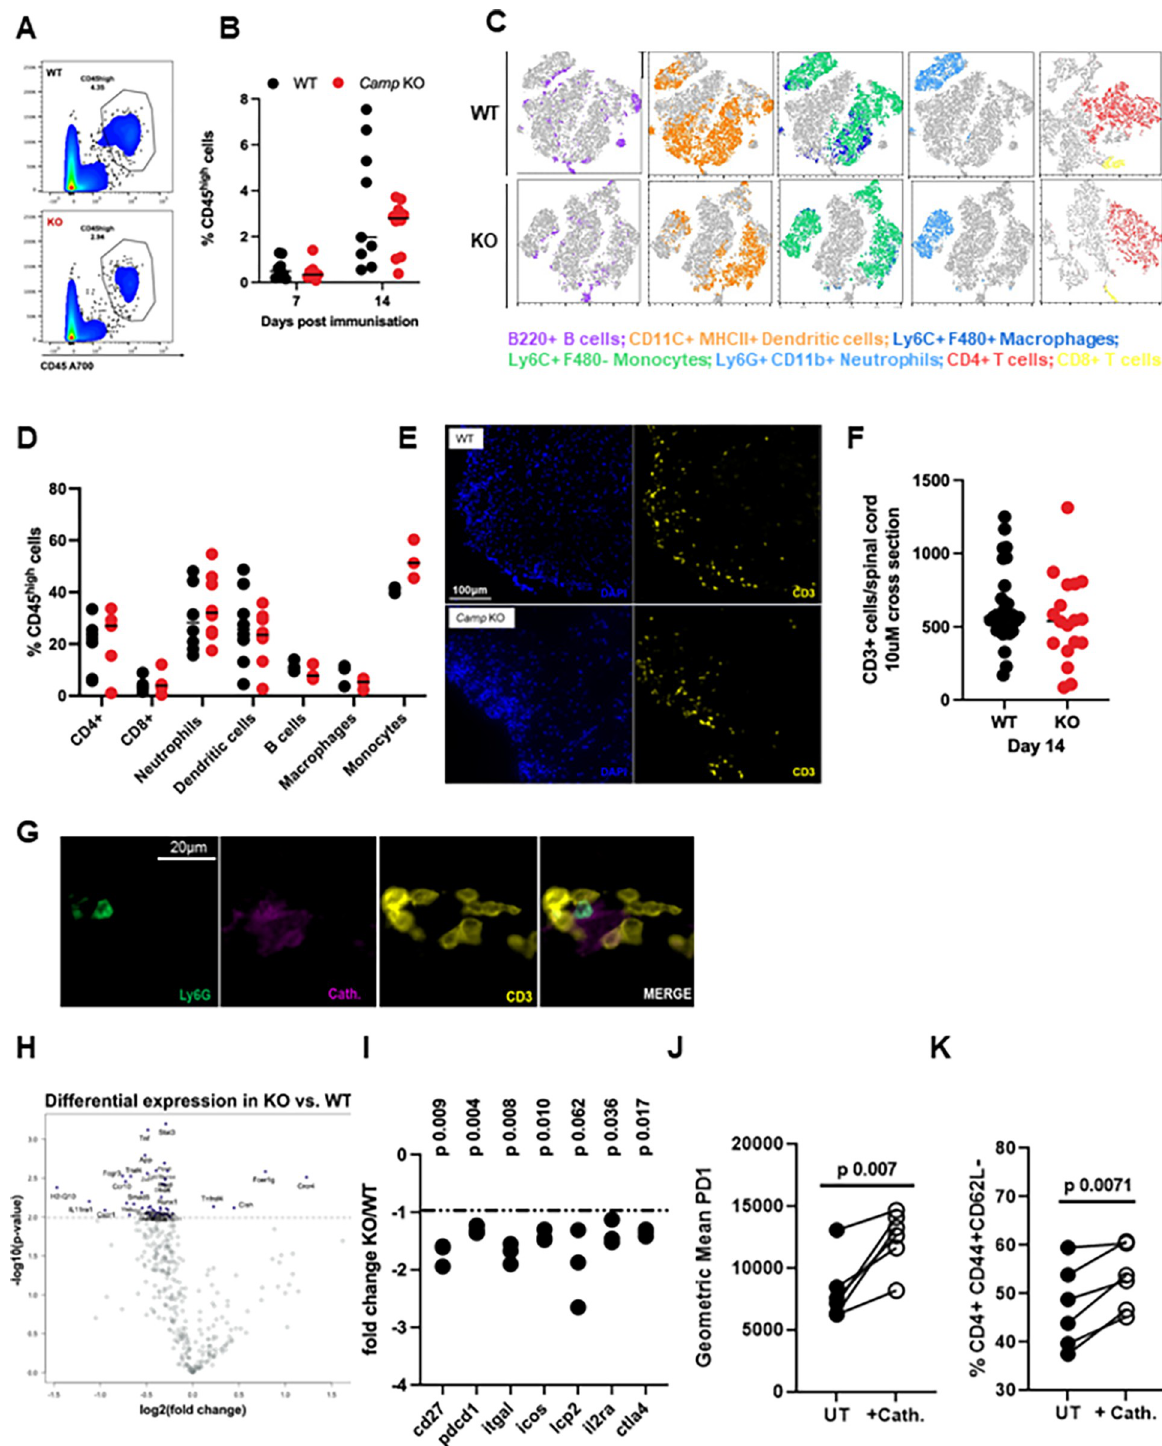
Fig 6. Mice lacking cathelicidin are resistant to induction of EAE despite normal infiltration of spinal cord T cells. EAE was induced in WT C57BL/6J and cathelicidin KO ( Camp−/− , KO) mice on day 0. (A, B) On days 7 and 14, CD45 high cell infiltration into the spinal cord was quantified by flow cytometry. (C, D) Immune cell subsets in the CD45 high gate were delineated on day 14 in the spinal cord then (E, F) CD3 + T cell numbers in the spinal cord were confirmed on day 14 by immunofluorescence. (G) Neutrophil release of cathelicidin was observed in close contact with T cells in the spinal cord. (H, I) On day 7 draining inguinal lymph nodes were removed and CD4 + T cells isolated. Gene expression